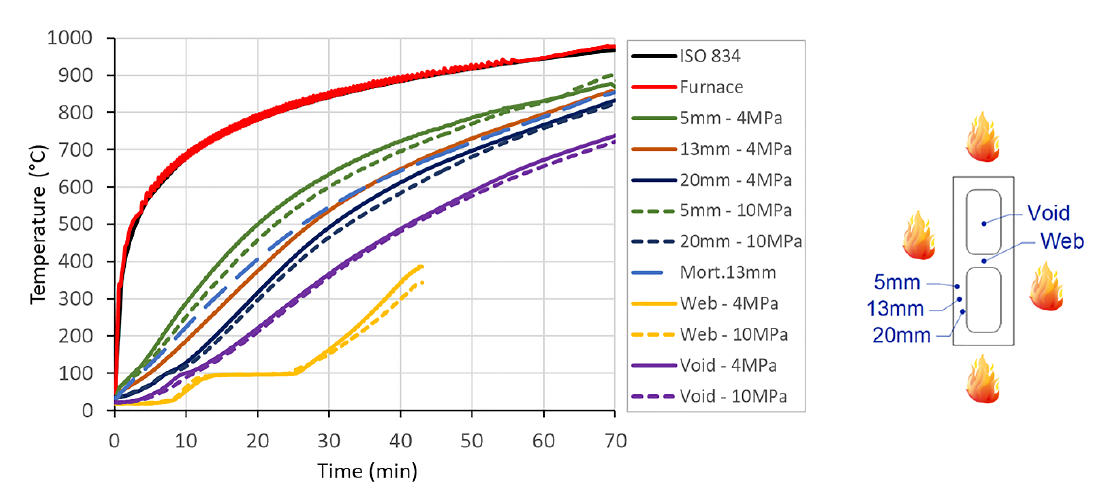
Figure 7. Blocks with fire acting on all their faces.